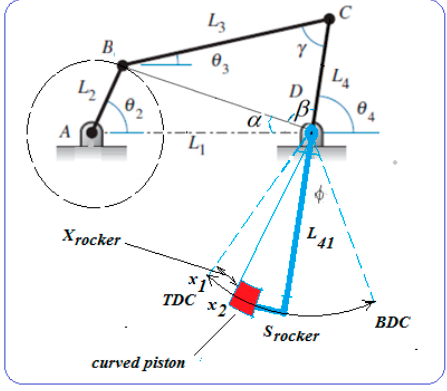
Figure 2. Geometry of the CR engine.